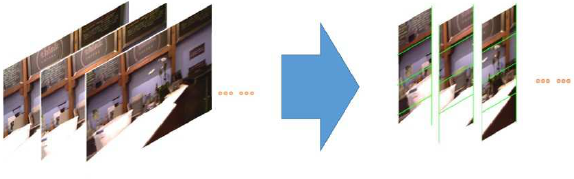
Figure 11. The whole image processing into deals only with a part of every